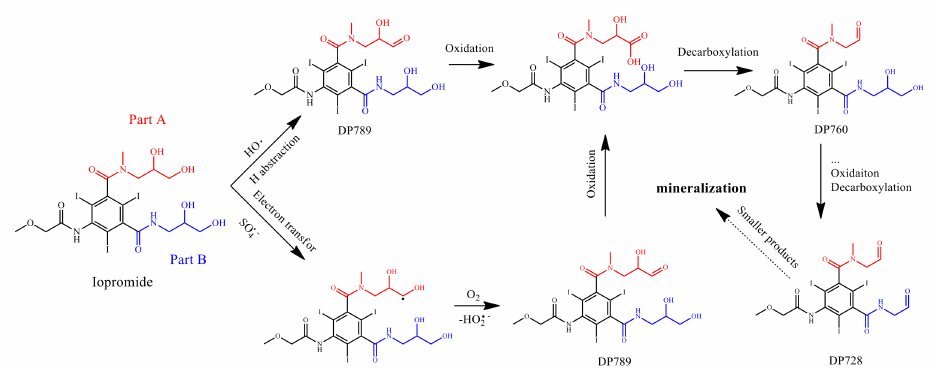
Figure 7. Proposed pathways for IOP degradation in the FeS/sulfite